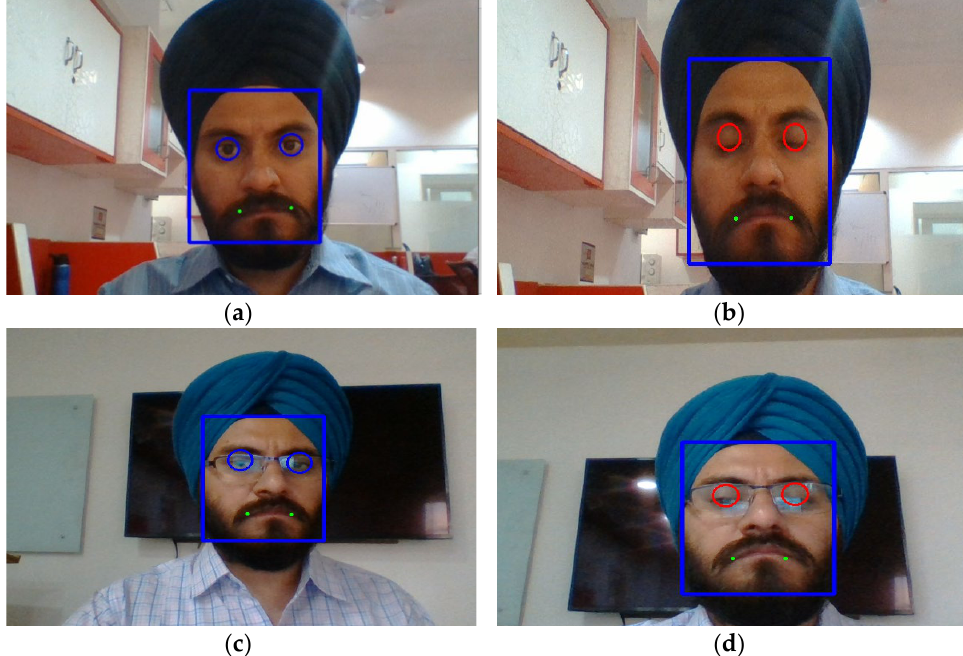
Figure 12. Detecting facial landmarks using MTCNN: ( a , b ) face with open and closed eyes in normal conditions; ( c , d ) face with open and closed eyes with glasses .